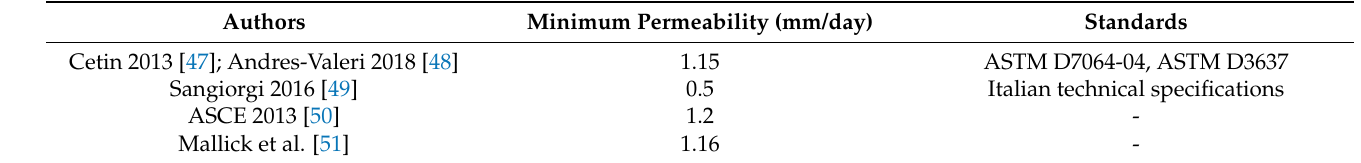
Table 4. Minimum